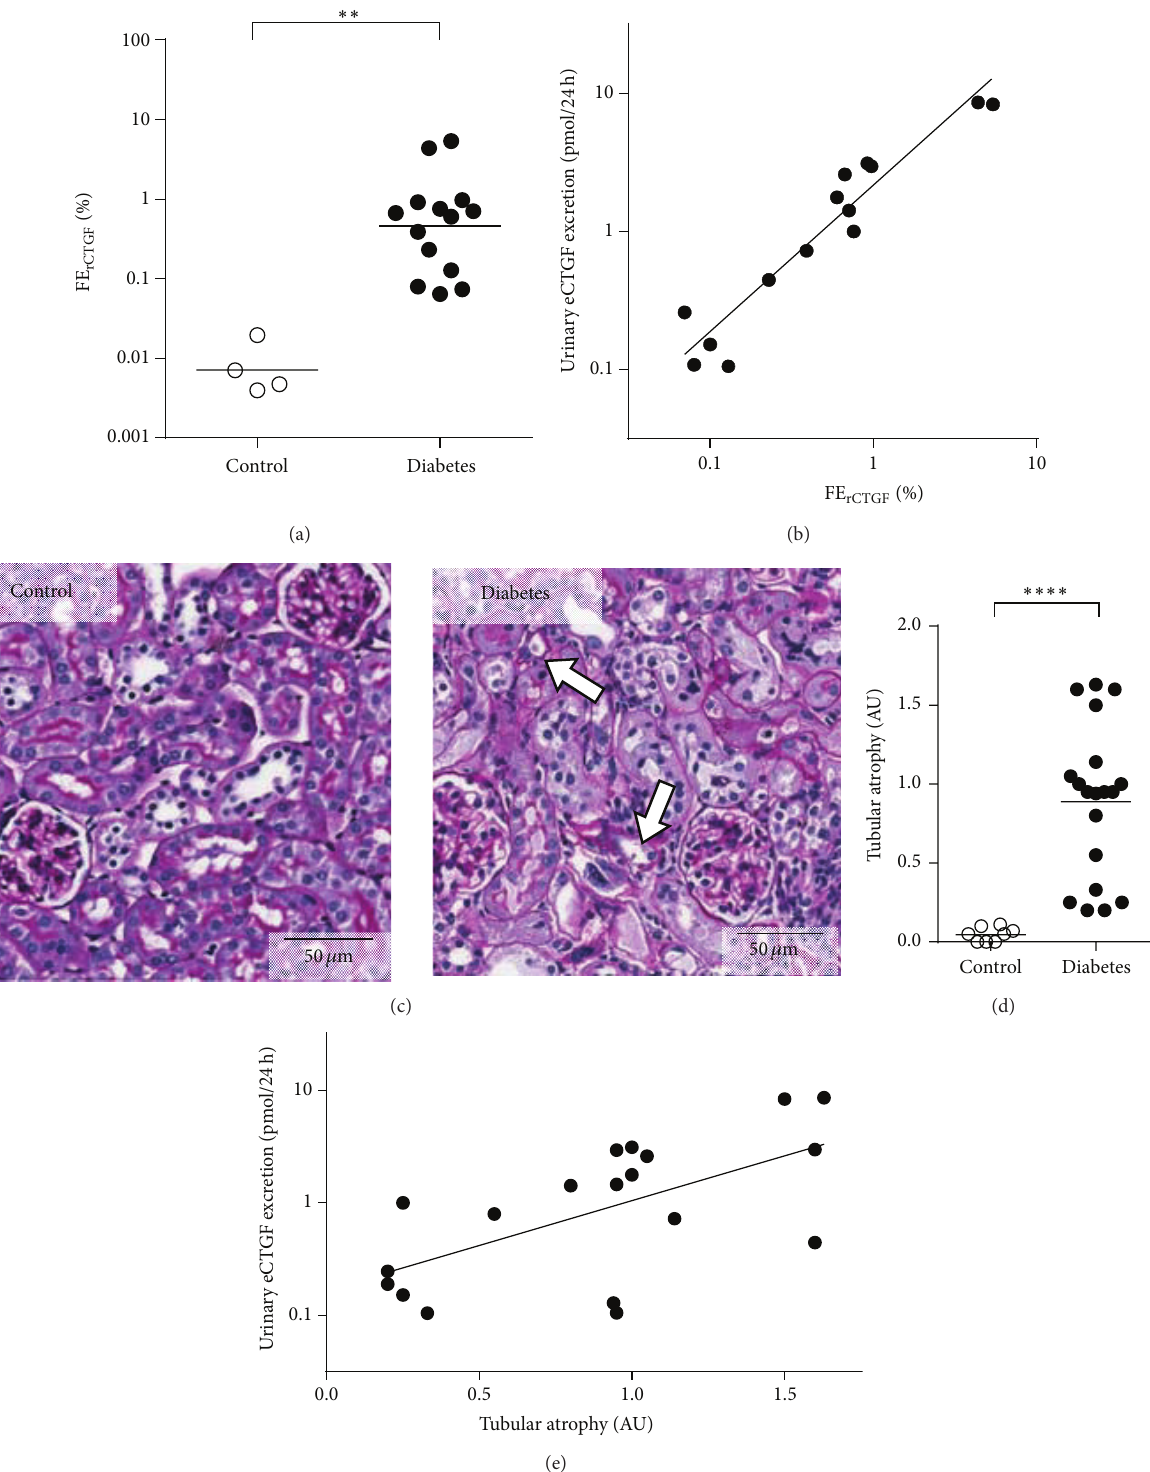
Figure 1: Urinary CTGF and tubular dysfunction in diabetic mice. (a) The fractional excretion of recombinant CTGF (FE rCTGF ), a measure of tubular reabsorption failure, is increased in diabetes, ∗∗ 𝑃 = 0.004 (Mann-Whitney 𝑈 test). (b) Urinary endogenous CTGF excretion (eCTGF) correlates tightly with FE rCTGF , 𝑟 = 0.95 , 𝑃 < 0.0001 . (c) Tubular atrophy is not present in control mice but clearly visible in diabetic mice (white arrows). (d) Semiquantitative evaluation shows increased tubular atrophy in diabetic versus control mice, ∗∗∗∗ 𝑃 < 0.0001 (Mann- Whitney 𝑈 test). (e) Urinary eCTGF correlates with tubular atrophy, 𝑟 = 0.62 , 𝑃 = 0.005